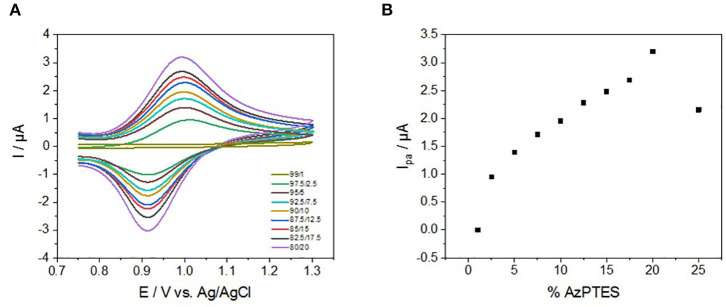
(A) Cyclic voltammograms of Fe(tpy)2-based silica films prepared from various TEOS/AzPTES ratios (total concentration of silane (TEOS + AzPTES): 200 mM) at 10 mV s−1 in 0.1M TBABF4 in acetonitrile. (B) Corresponding variation of the anodic peak current as a function of the % AzPTES in the starting sol.